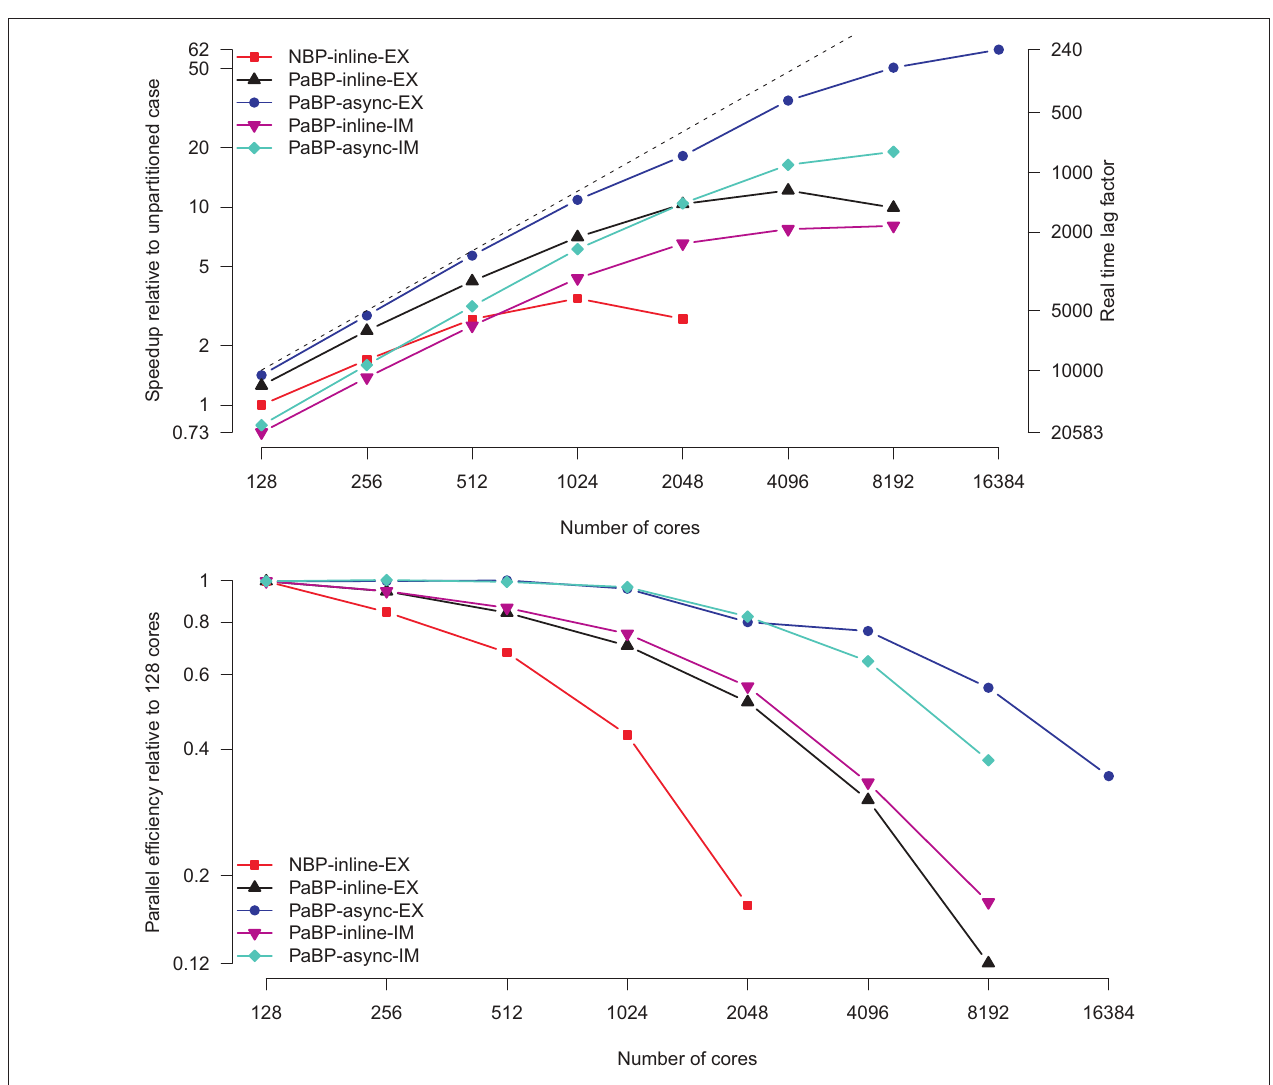
Figure 3 | Benchmark results of strong scalability experiments. Shown are the effects of nodal-based (NBP) versus ParMeTis-based (PaBP) domain decomposition, implicit (IM) versus explicit (EX) solver strategy, and inline versus